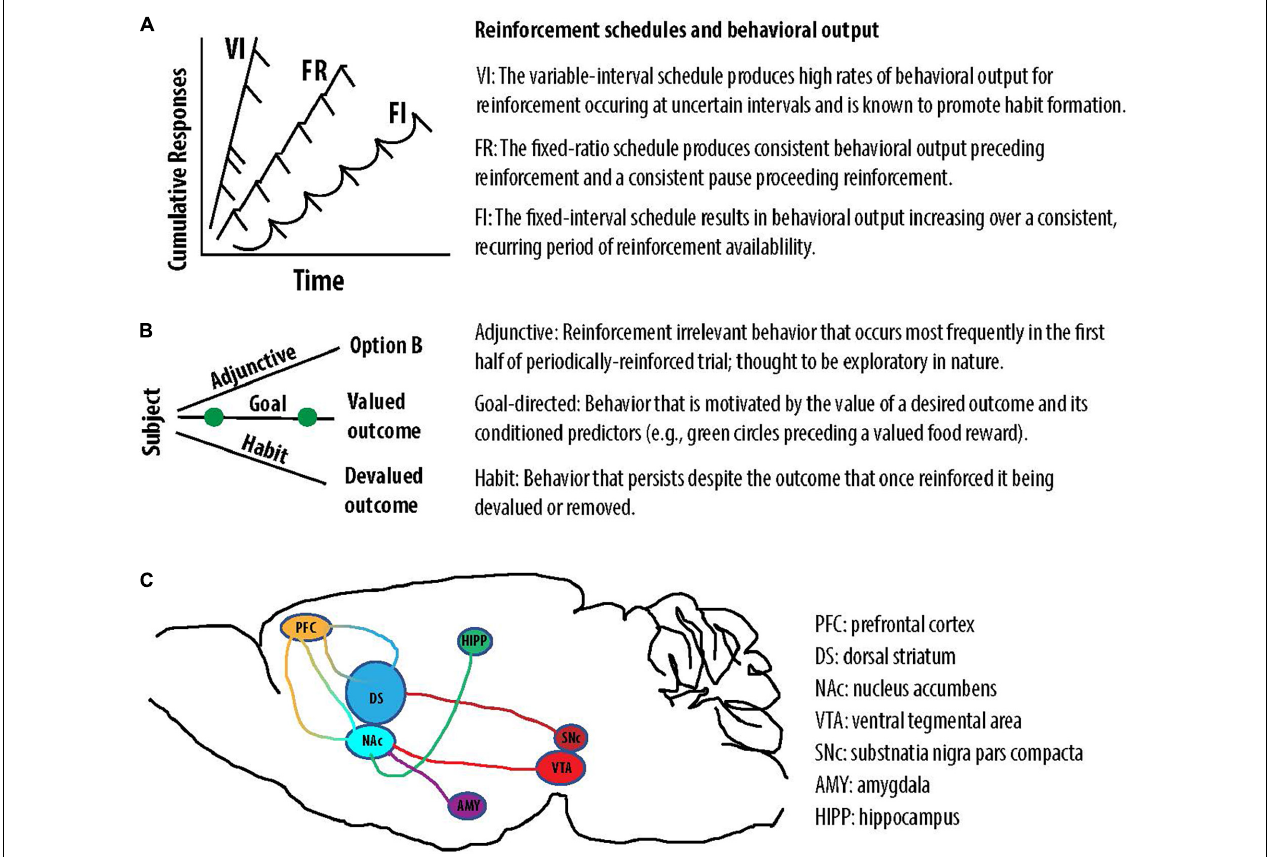
FIGURE 2 | Reinforcement schedules engender distinct behaviors and a depiction of two DA pathways. (A) The VI, FR, and FI schedules produce unique patterns of reinforced behavior. (B) The contingencies of reinforcement can produce adjunctive, goal-directed, or habitual behavior. (C) Illustrative projections associated with the nigrostriatal (dark red) and mesocorticolimbic (light red) DA pathways. DA in the NAc is thought to modulate converging input from brain regions including the amygdala (AMY), hippocampus (HIPP), and prefrontal cortex (PFC). Cortico-striatal loops are depicted in multicolor